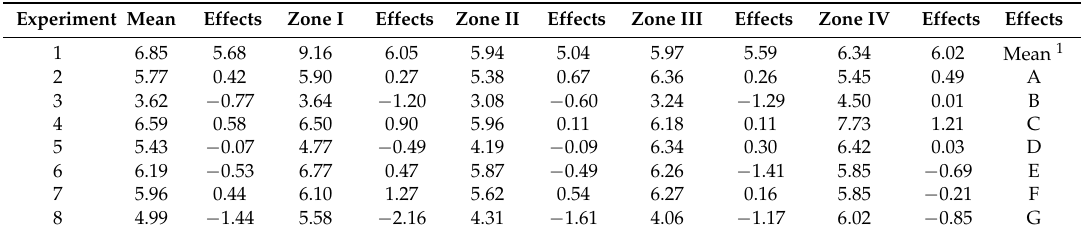
Table 7. Calculation of the Effects by means of Yates’ Algorithm, for the percentage of volume fraction of Graphite,